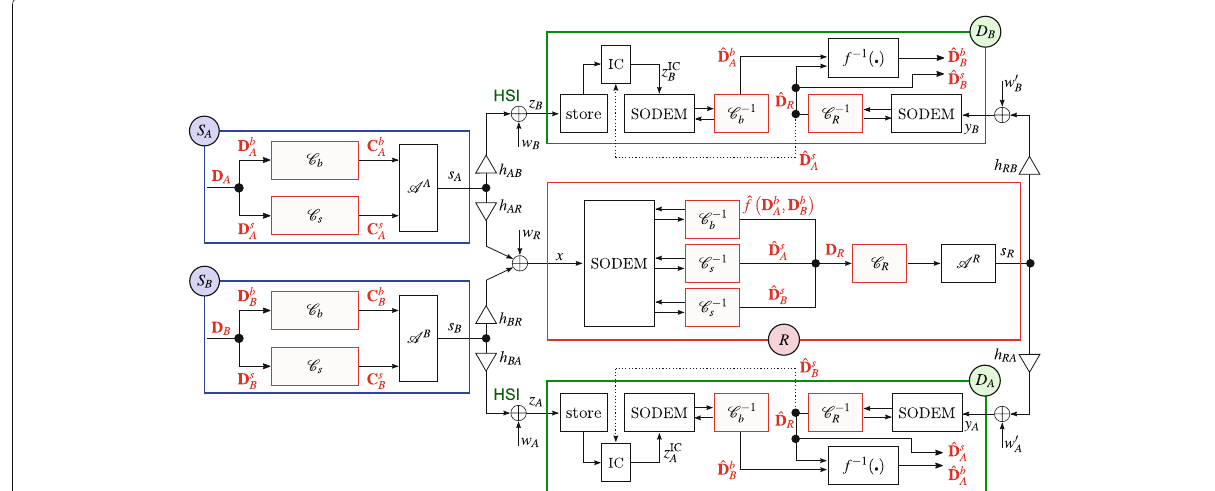
Fig. 12 Relaying scheme in the encoded WBN system. SODEM stands for a soft-output demodulator, IC is the interference canceler. The channel encoders/decoders which are appended to the uncoded system are